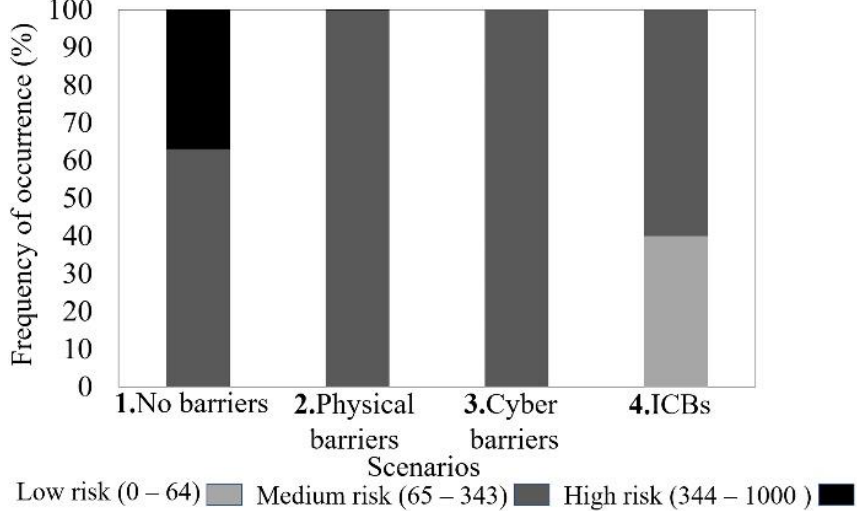
Figure 5. Frequency of occurrence of cyber-physical risk levels per scenario.